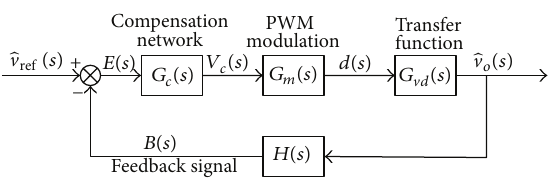
Figure 3: DC-DC converter